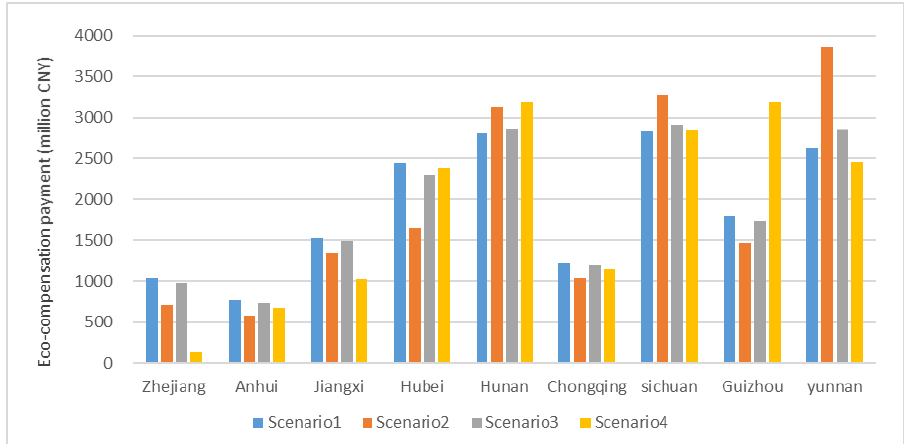
Figure 7. Eco-compensation payment allocation among nine provinces in the Yangtze River Eco- nomic Belt in different scenarios (The four scenarios are explained in Section 3.3).